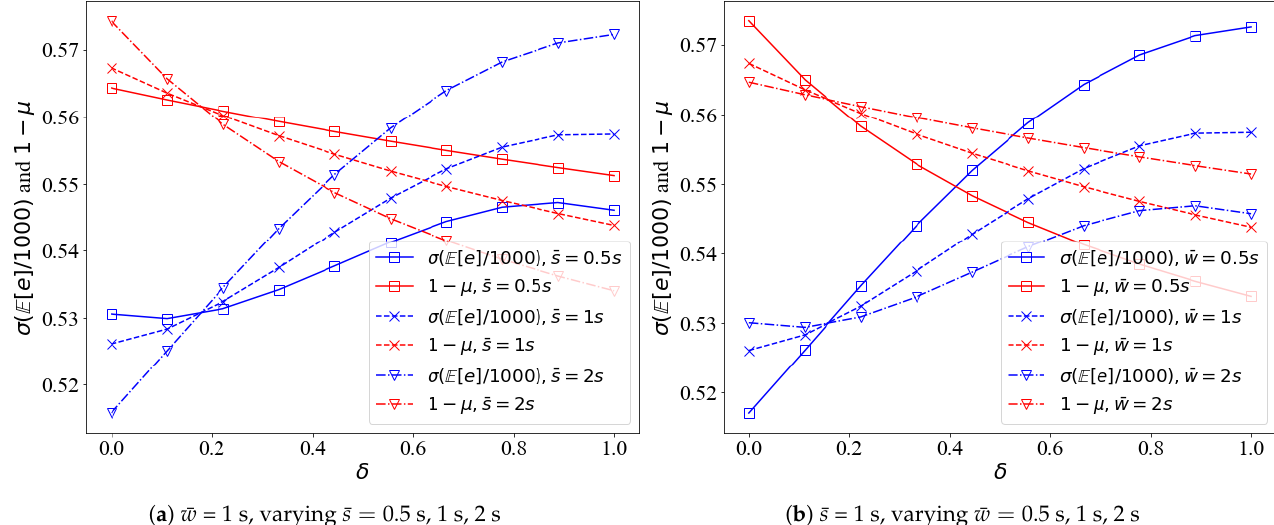
Figure 10. The detection accuracy and energy depletion against δ . ( a ) ¯ w is fixed to 1 s, varying ¯ s ; ( b ) ¯ s is fixed to 1 s, varying ¯ w .